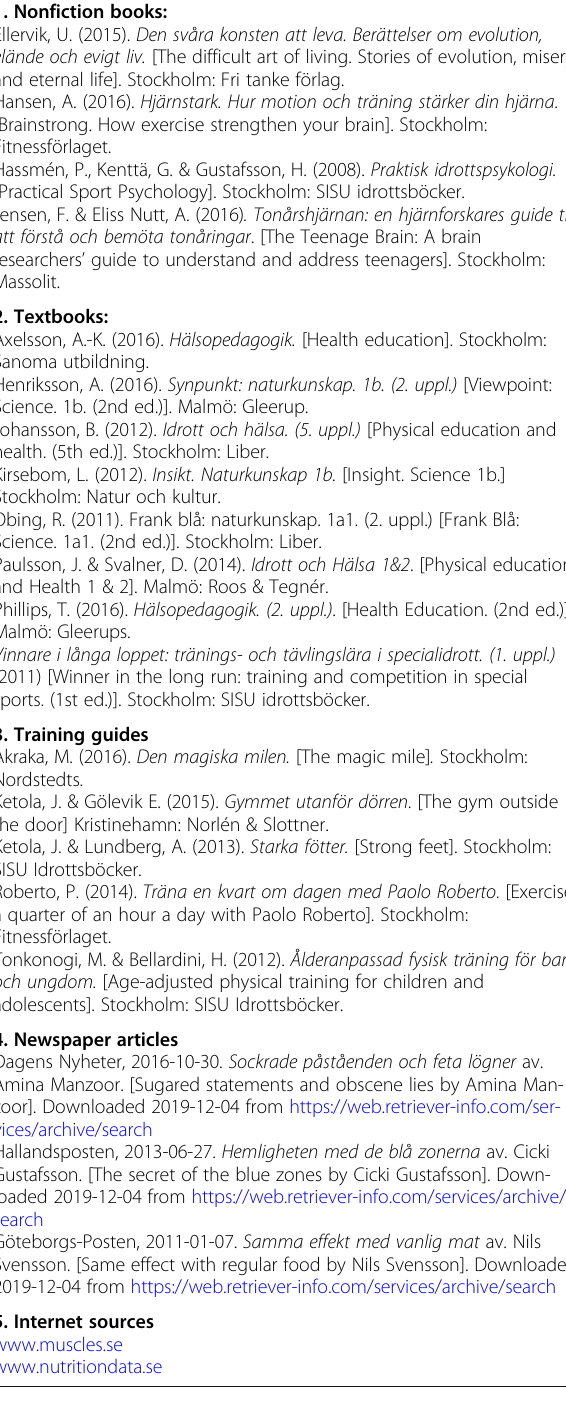
Table 1 List of teaching material